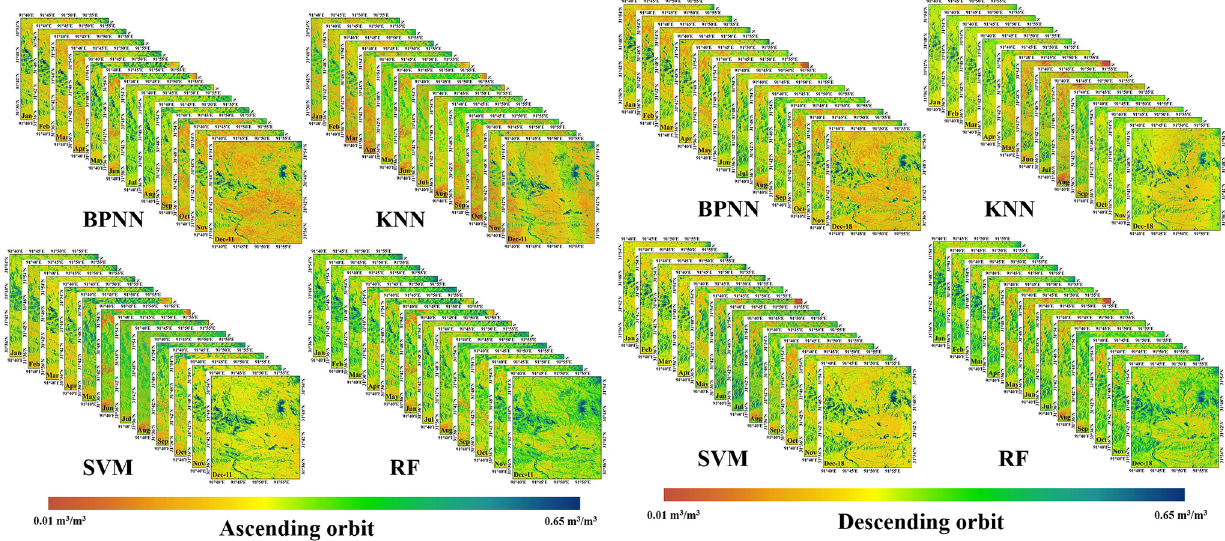
Figure 8. Soil moisture inversion results with machine learning algorithms for ascending and descending orbits of Naqu network for 2020.